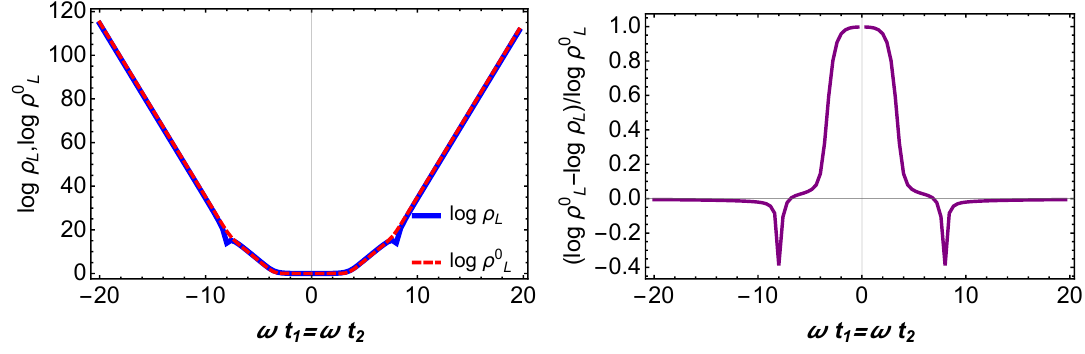
− log ρ ) / log ρ 0 L L L